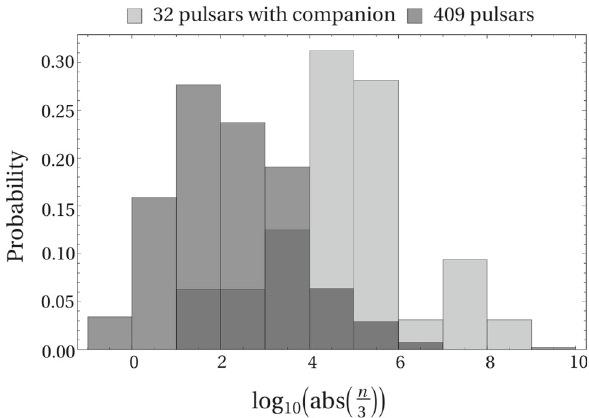
Fig. 1 Probability distribution of braking indices for the pulsars. The light gray filled histogram is the braking indices of 32 pulsars with companions. The gray filled histogram is the braking indices of the rest 409 pulsars. The dark gray filled histogram is the cross region of these two kinds of